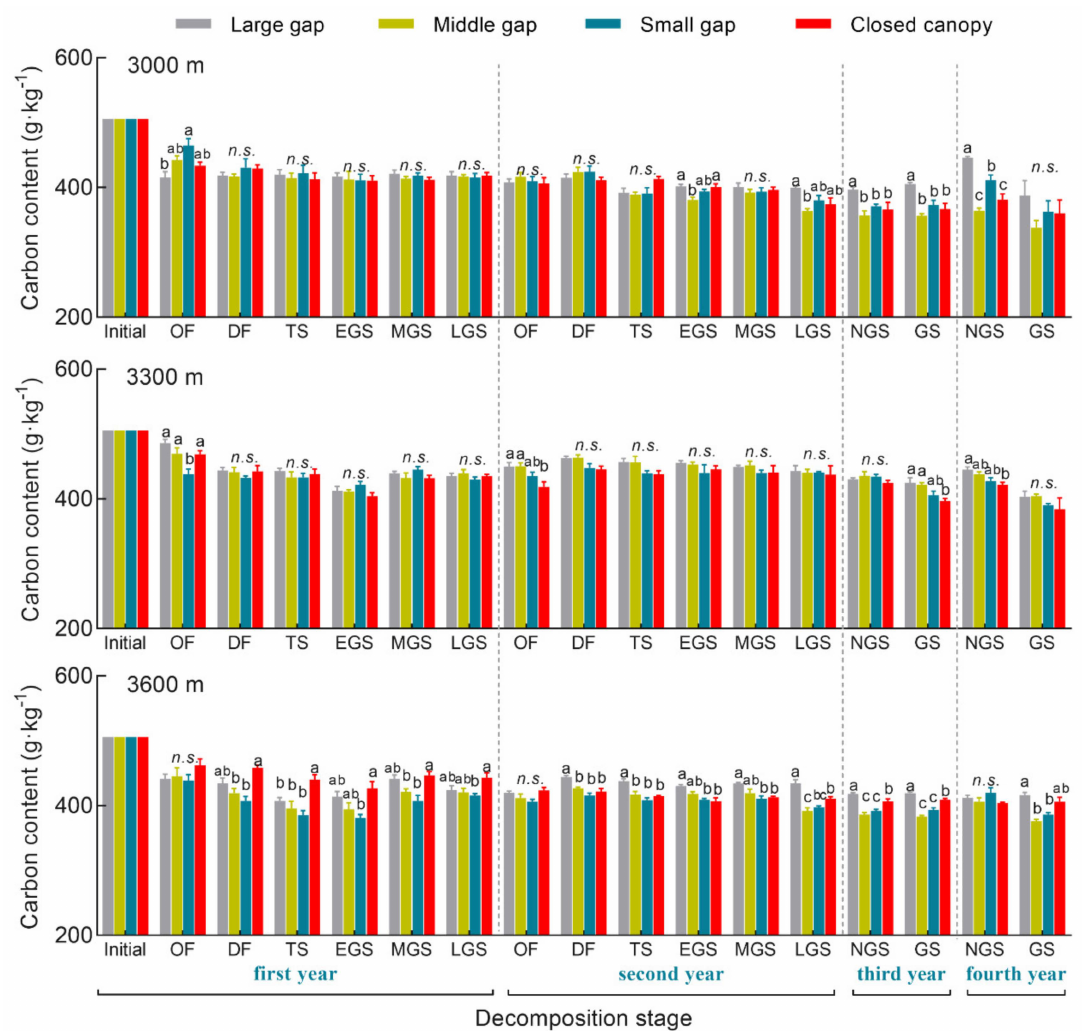
Figure 3. Carbon content of A. faxoniana litter in forest gaps (large gap, middle gap, small gap, closed canopy) along an elevation gradient (3000, 3300, 3600 m) at different decomposition stages in a subalpine forest of southwestern China. Mean ± SE, n = 3. OF, onset of freezing stage; DF, deep freezing stage; TS, thawing stage; EGS, early snow-free stage; MGS, middle snow-free stage; LGS, late snow-free stage; NGS, non-growing season; GS, growing season. Lowercase letters indicate significant differences among forest gaps ( p < 0.05), n.s . indicates no significant differences ( p >